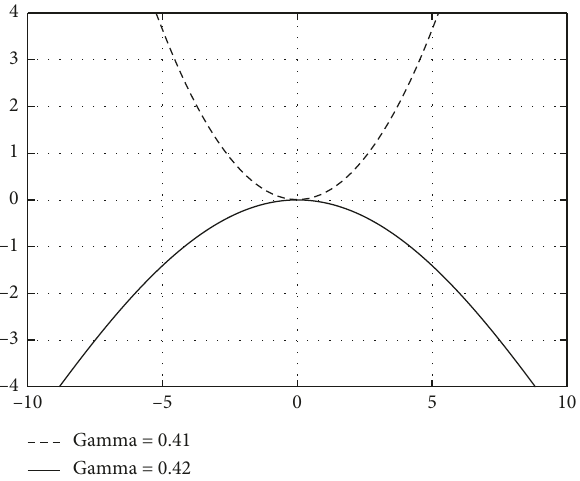
Figure 7: Illustration of the Hamilton function.